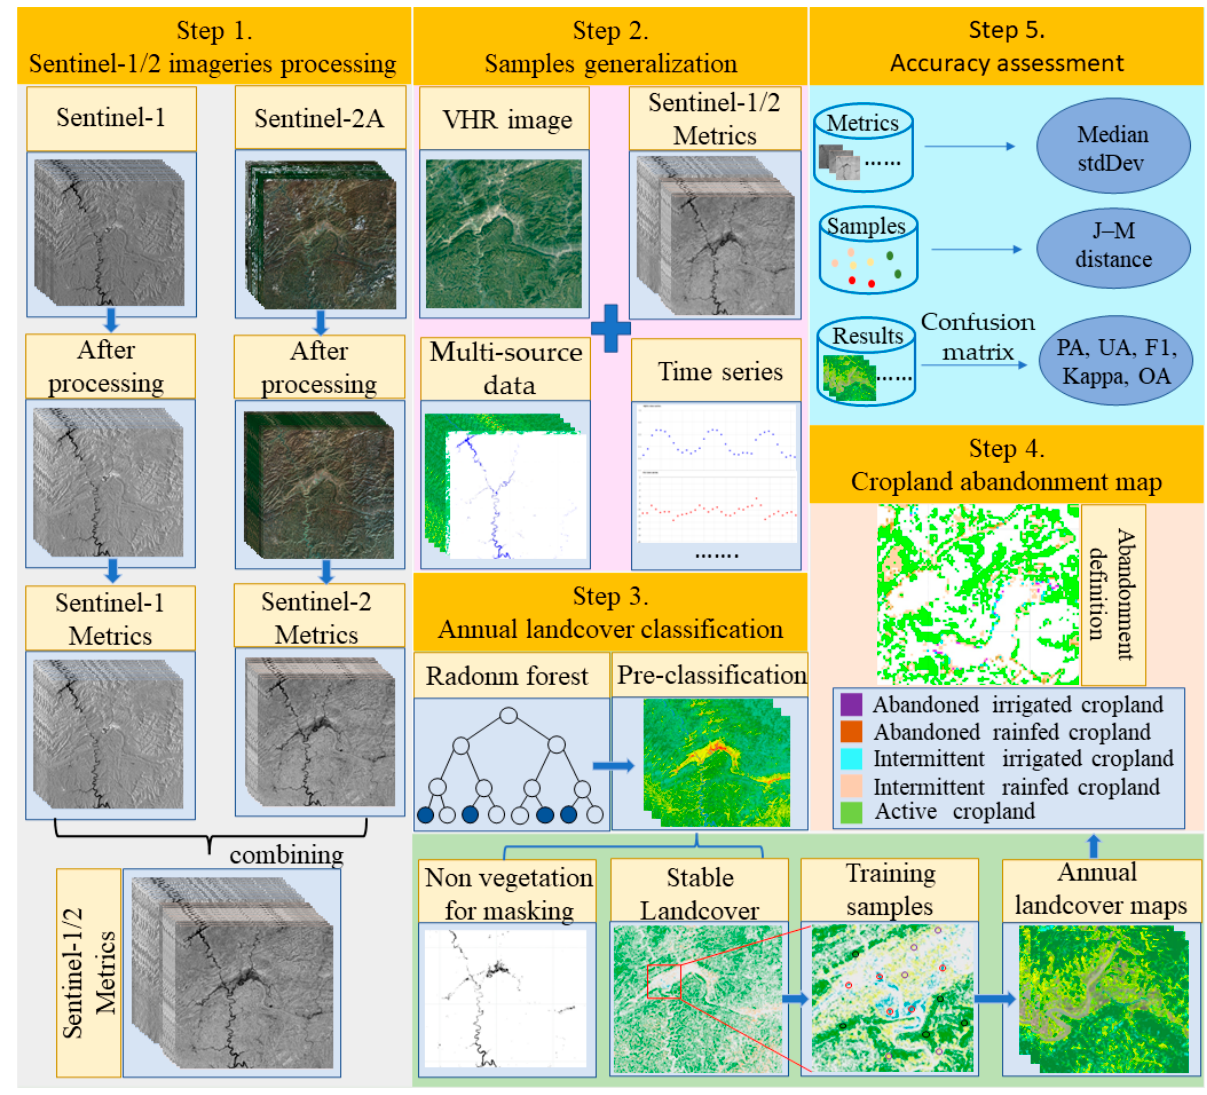
Figure 2. Flowchart of extracting abandoned cropland in hilly areas.